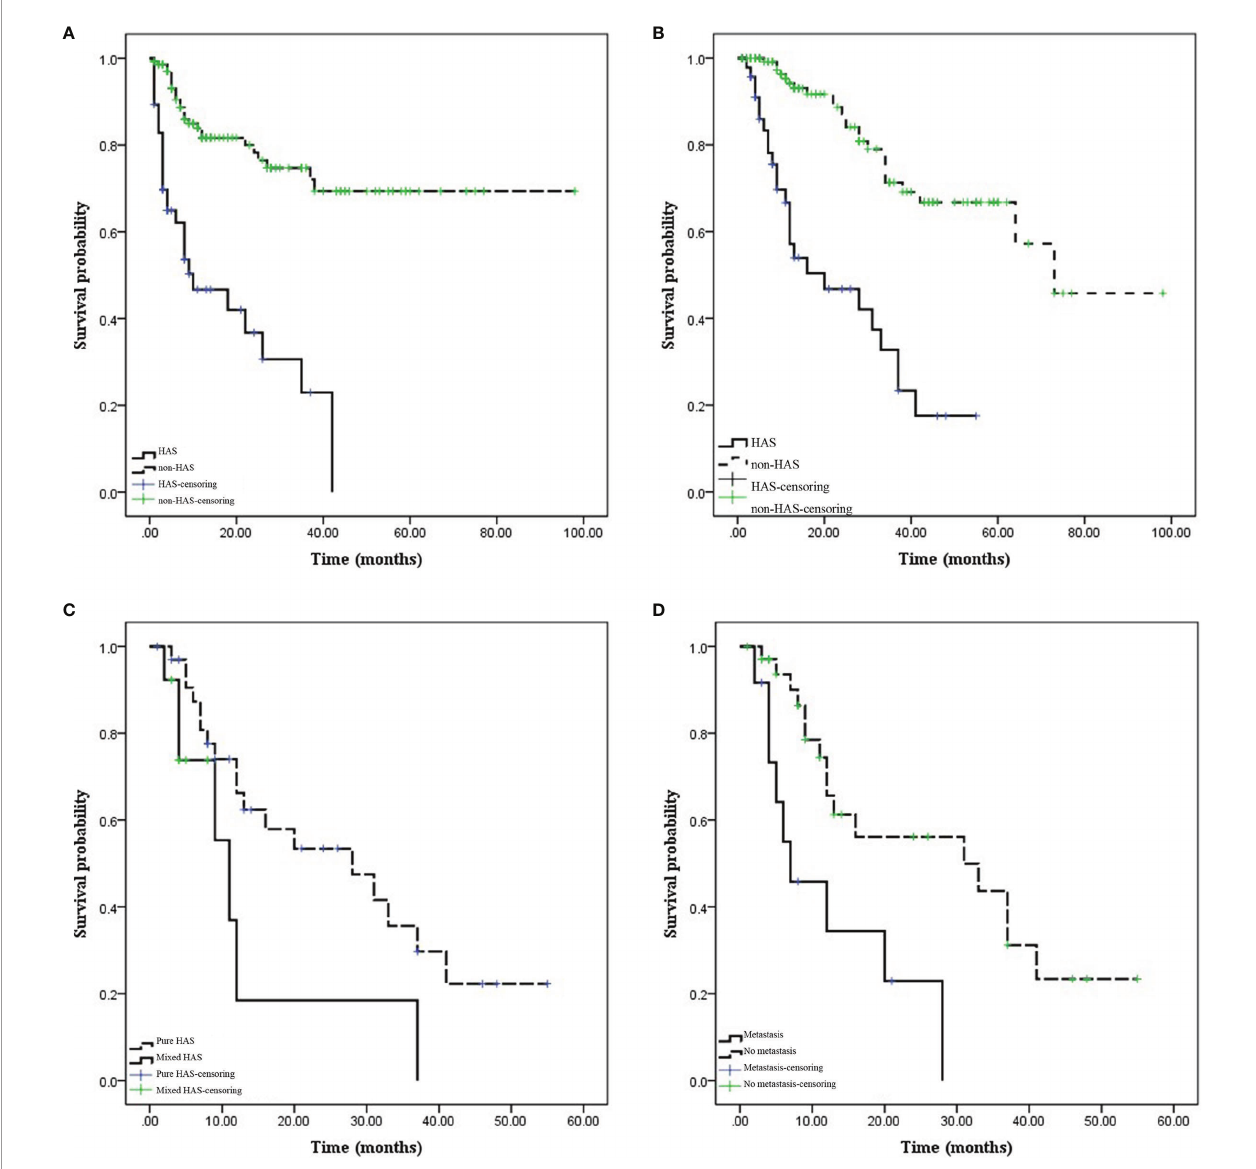
FIGURE 8 | Comparison of prognosis between hepatoid adenocarcinoma of the stomach (HAS) and non-HAS cases. (A, B) Survival curves (progression-free survival [PFS] and overall survival [OS]) of the HAS and non-HAS groups. The PFS and OS were signi fi cantly shorter in the HAS group than in the non-HAS group. (C) Effects of the pure HAS (pHAS) and mixed HAS (mHAS) types on the OS of HAS. (D) Effect of M stage on the OS of HAS. The OS was shorter for mHAS and distant metastatic